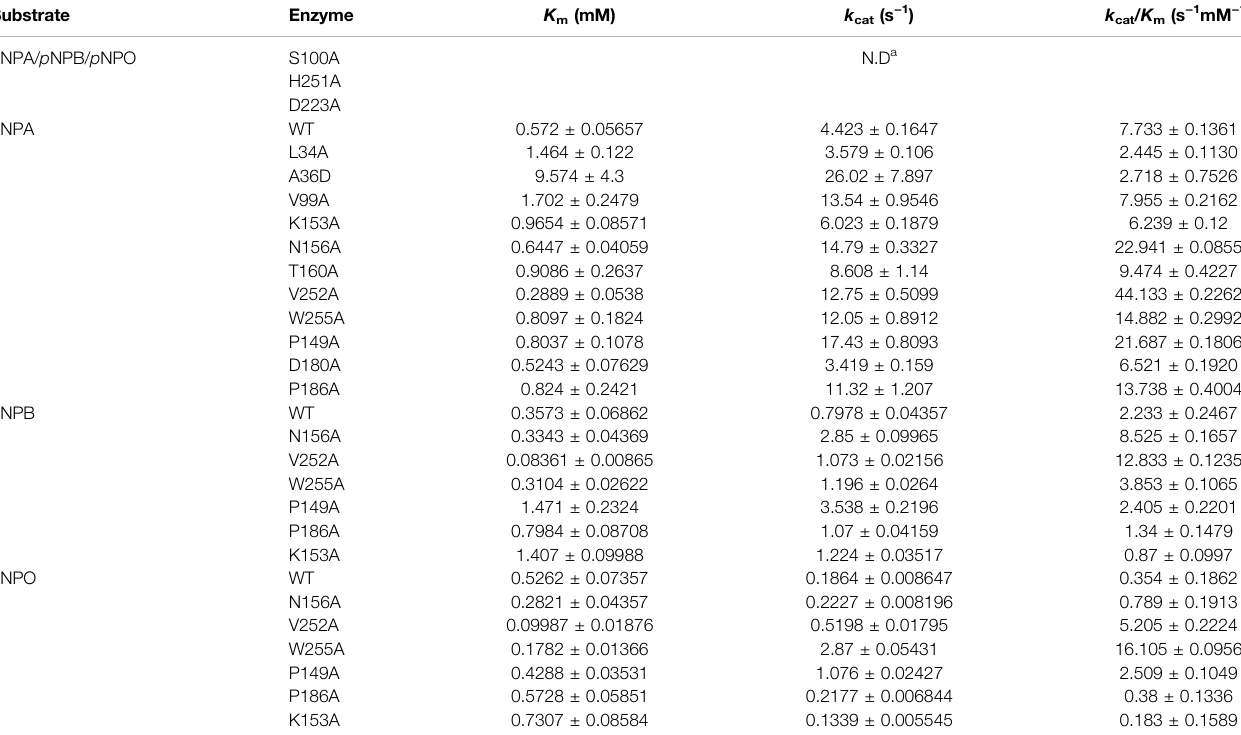
TABLE 1 | Kinetic parameters of wild-type Df FAE and its mutants.